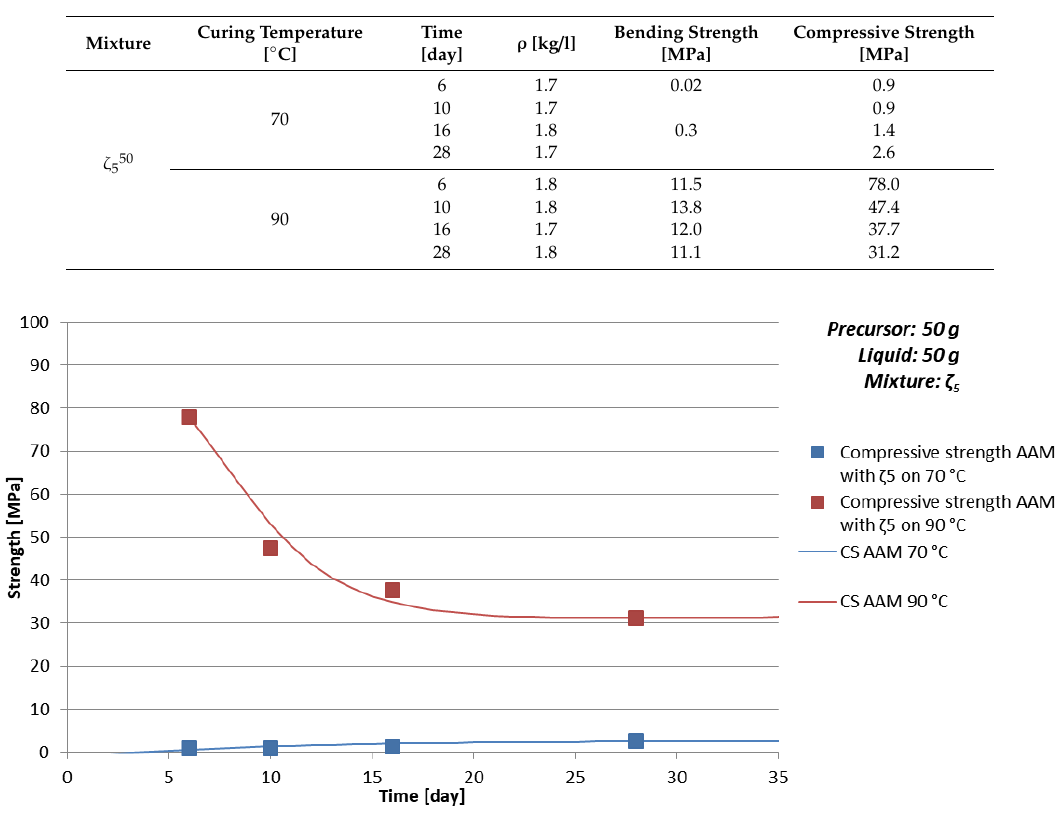
Figure 6. Time dependence of compressive strength of AAM prepared with mixture ζ 5 , cured on 70 °C (blue) for one day and cured on 90 °C (red) for one day. Lines represented approximation of the compressive strength time development behaviour 𝐶𝑆 ↑ (blue, Equation (16)) and 𝐶𝑆 ↓ (red, Equation (17)).